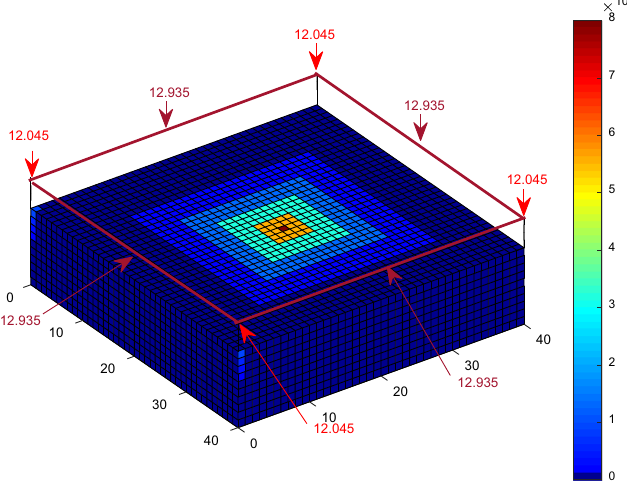
Figure 9. Lightning strike probability to a cuboid with catenary wires using K P2C .